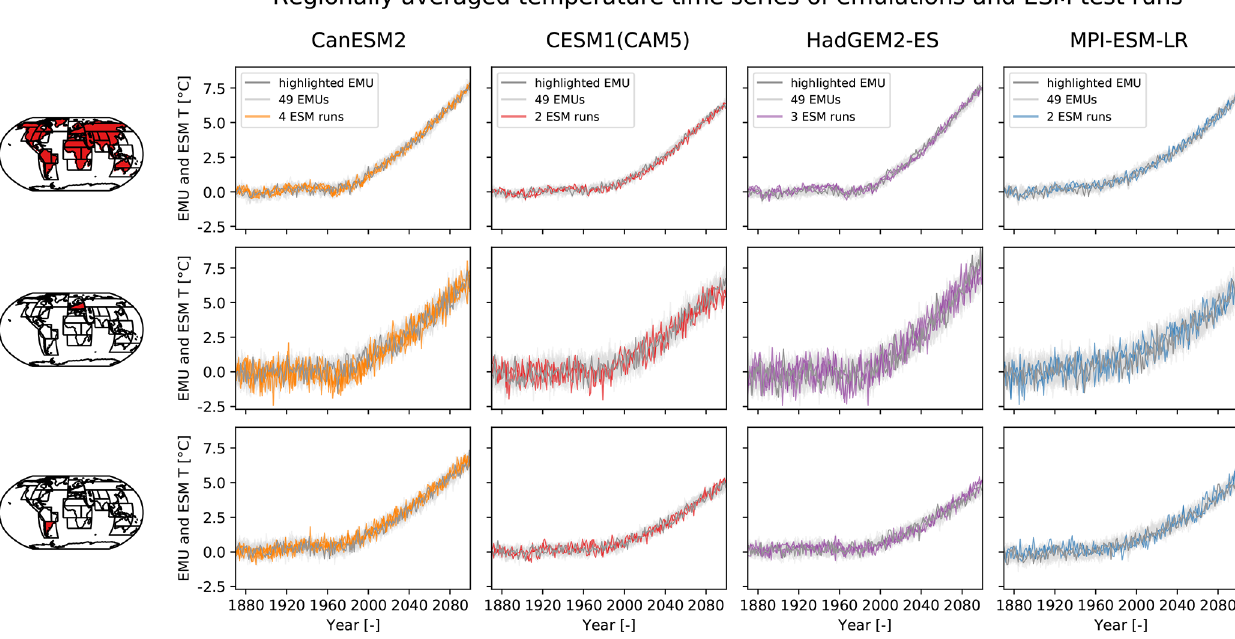
Figure 5. Regionally averaged temperature time series (rows) for four example ESMs (columns). The regions are (from top to bottom) global land, Central Europe (CEU), and Southeastern South America (SSA). In each panel, one emulation (EMU) is highlighted in dark gray and 49 other emulations are shown in light gray. Additionally, all available ESM test runs are plotted in